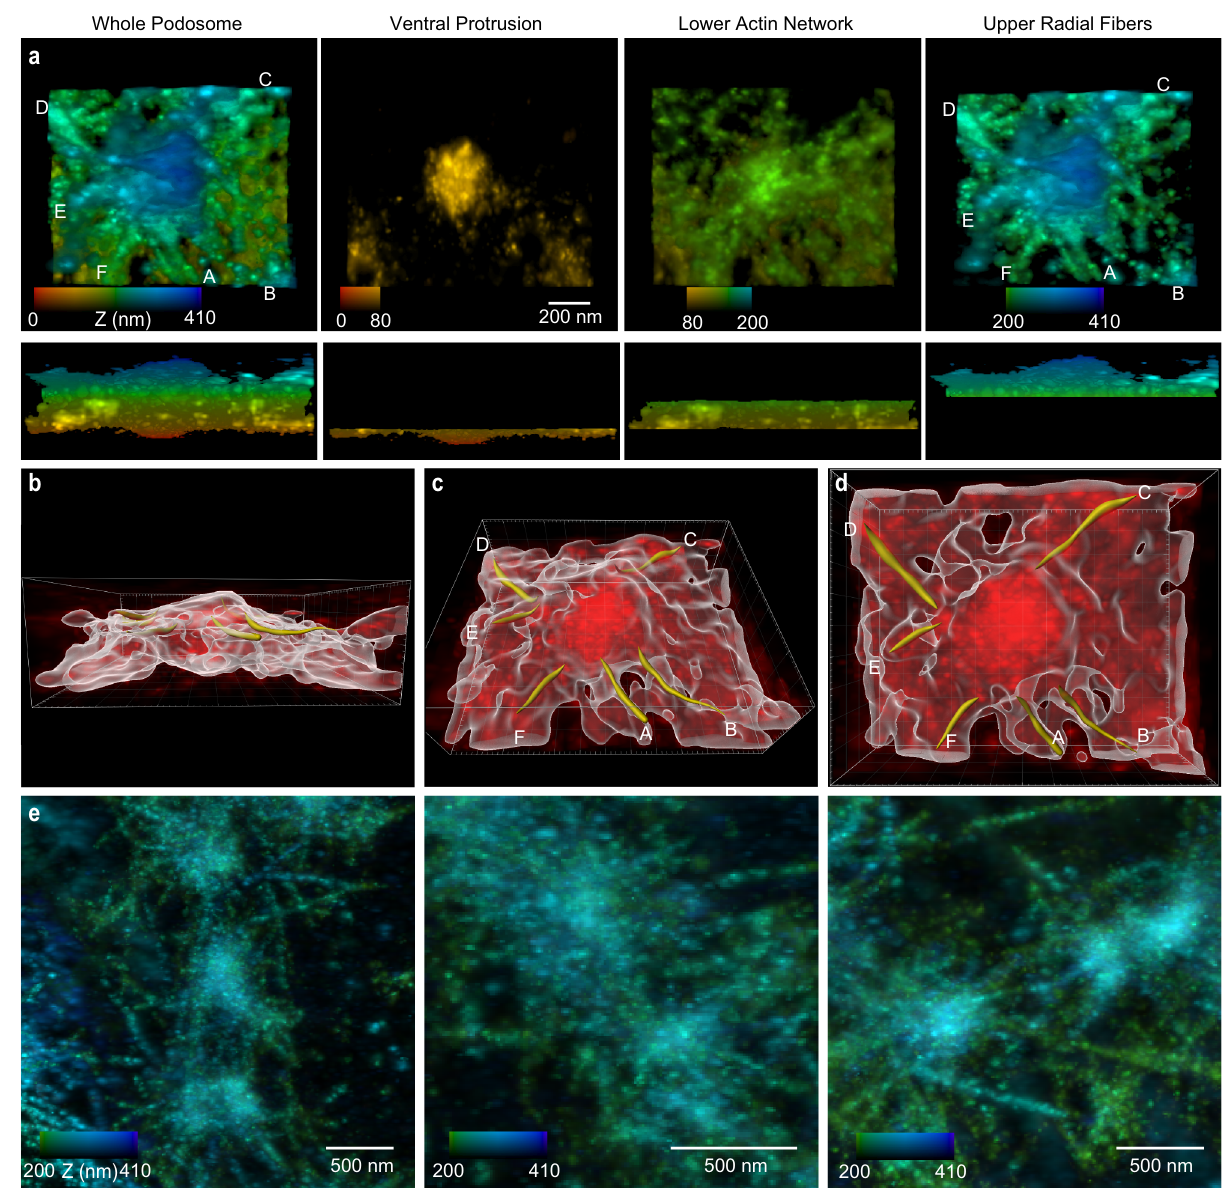
Fig. 6 | Characterization of radial fi laments around individual podosomes. a Volumetric (3D) visualization of a podosome viewed from the top (top row) and side (bottom row). From leftto right: whole image stack, 0 to 410nm; 0 to 80nm; 80 to 200nm; 200 to 410nm. Radial fi laments around the central podosome core are labeled A – F. b – d Radial traces for fi laments A-F are produced by 3D object